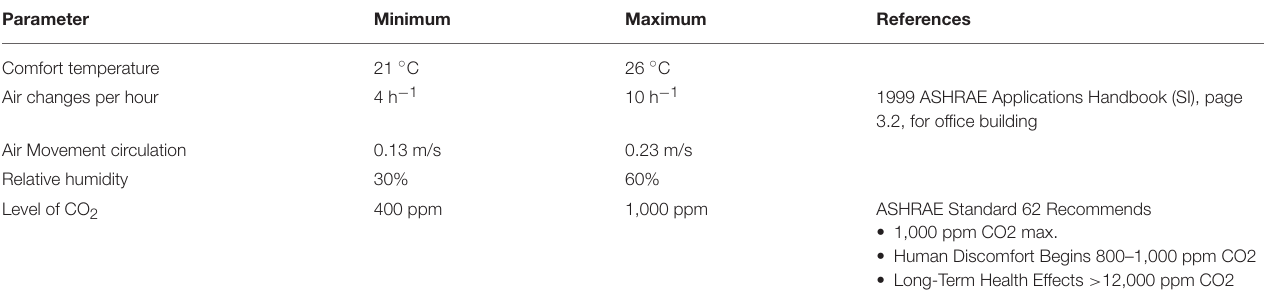
TABLE 4 | General design criteria.